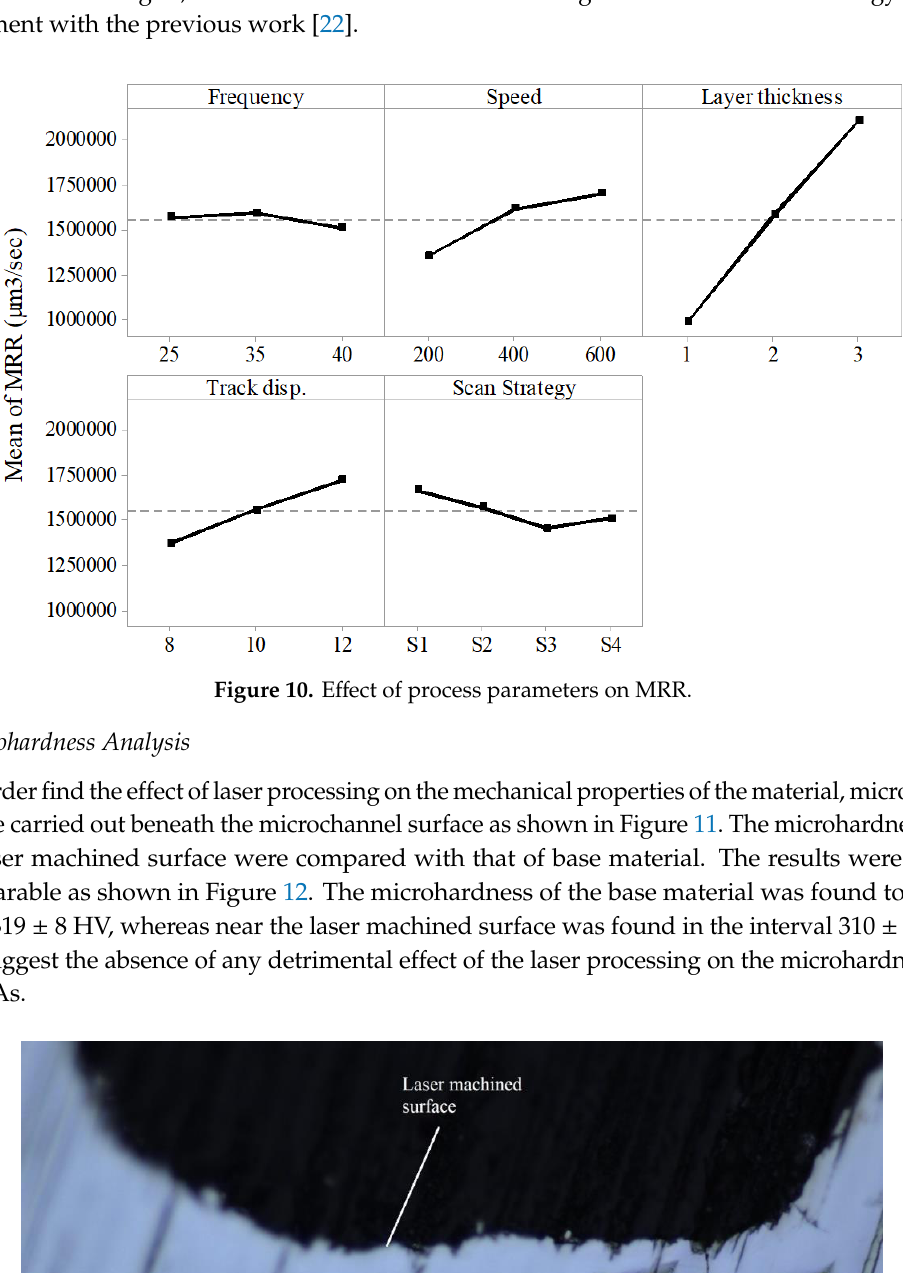
Figure 12. Microhardness comparison between laser machined surface and base material. 3.6. Optimization Multi objective optimization was performed in order to find the optimal parameters minimizing taper angle and spatter around the periphery of the microchannel while keeping the TWE and MRR as constraints within a range as shown in Table 3. Multi objective optimization is carried out using multi objective genetic algorithm (MOGA-II) and RSM in modeFRONTIER ® software (Version 4.0, Esteco SPA, Trieste, Italy), the optimization workflow is shown in Figure 13. MOGA-II is an effective algorithm that uses smart elitism for multi-objective search. The elitism operator prevents convergence to local optima. The algorithm considers a total of number of